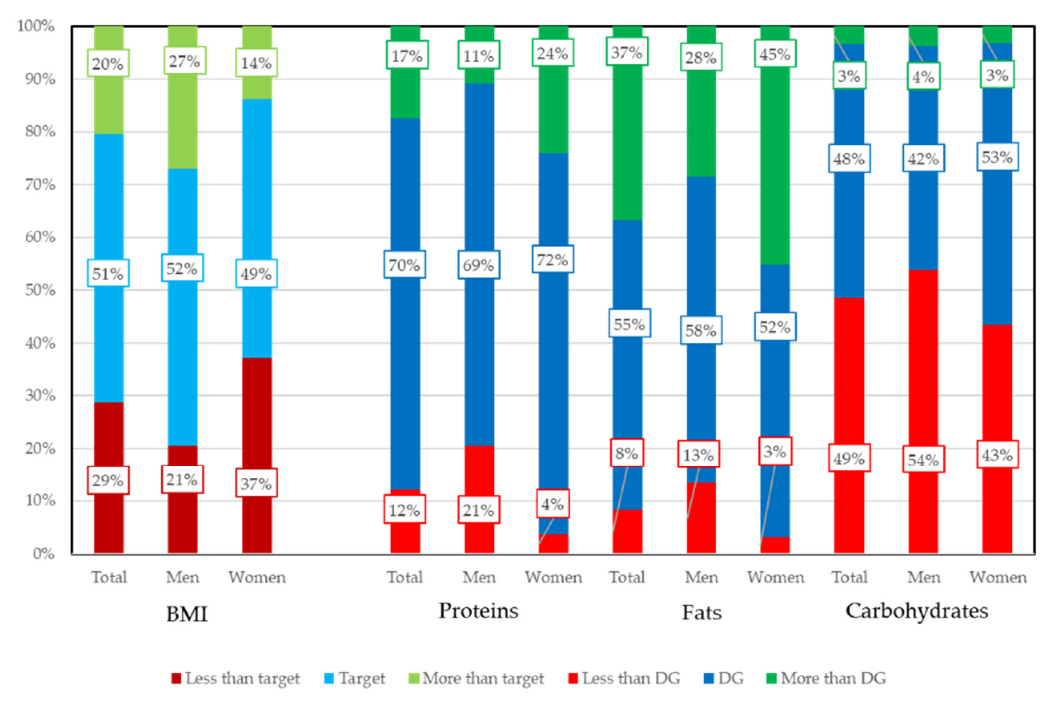
Figure 1. Proportion of subjects for BMI and meeting Tentative Dietary Goal for preventing lifestyle related diseases. Energy balance on three major nutrients are set in Dietary Reference Intakes for Japanese as Tentative Dietary Goal for preventing lifestyle related diseases (DG). DG for three major nutrients are expressed by percent of energy intakes. When comparing men and women, distributions were all statistically significant by χ 2 tests. Target BMI ranges are 20.0–24.9 (kg / m 2 ) for 50–69 years old and 21.5–24.9 (kg / m 2 ) for 70 years or older. Target BMI range is common to men and women. Optimal range of Body Mass Index (Target BMI) and Tentative Dietary Goal for preventing lifestyle related diseases (DG) are set in Dietary Reference Intakes for Japanese.